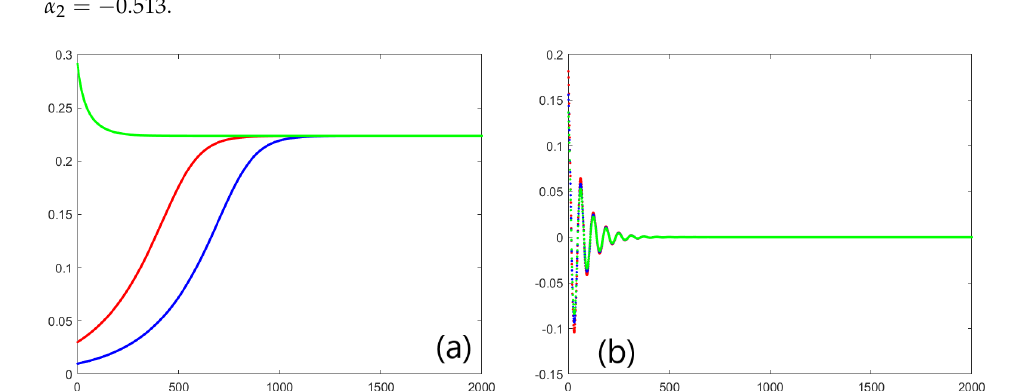
Figure 13. Numerical simulation for the map (9) when β 1 ( α ) = 2 α 3 α 1 α 2 − α 2 : ( a ) the three orbits are represented here with ( ρ 1 , ϕ 1 ) = ( 0.01,0 ) , ( ρ 1 , ϕ 1 ) = ( 0.03,0 ) and 2 ( ρ ) = ( 0.3,0 ) , respectively, and α 1 , ϕ 1 with ( ρ 1 , ϕ 1 ) = ( 0.183,0 ) , ( ρ 1 , ϕ 1 ) = ( 0.16,0 ) and ( ρ 1 , ϕ 1 ) = ( 0.14,0 ) , respectively, and α 1 = 0.5, α 2 = − 0.513.